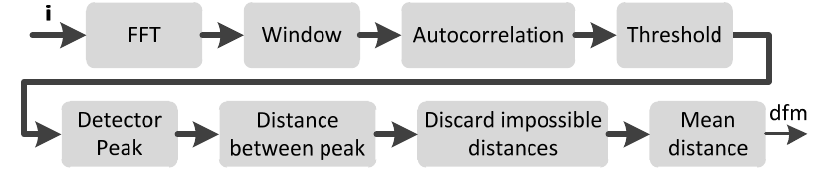
Figure 4. Block diagram of the df m Estimator block when ex _ dfm is Ture . FFT: Fast Fourier Transform.